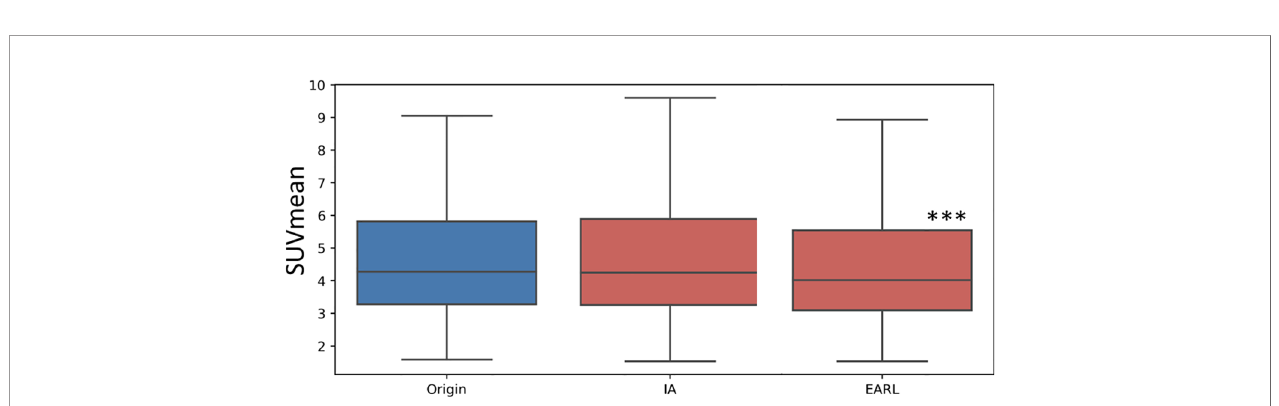
FIGURE 4 | Box plot of the mean SUV value in lesion in Original, AI and EARL1-like images. The distribution difference between the original images and AI is not signi fi cant (p=0.06) while it is signi fi cant (p<0.001 ***) between original and EARL1-like